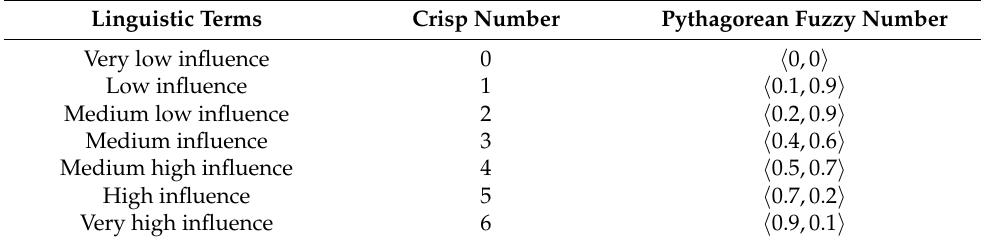
Table 2. Linguistic variable in Pythagorean fuzzy